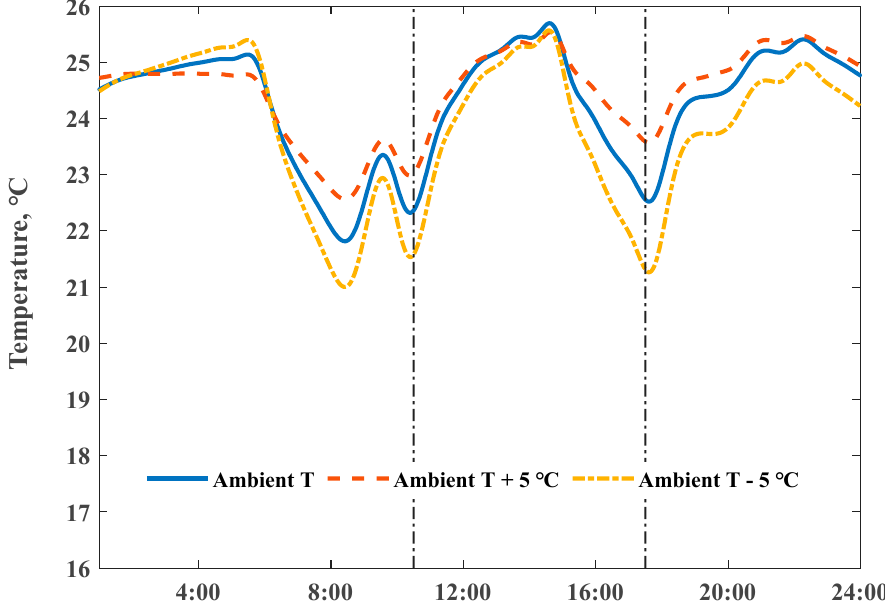
Figure 12. Impact of ambient temperature on the simulated indoor air temperature profiles with a Q value of 1.91 W/ ( m 2 · K )